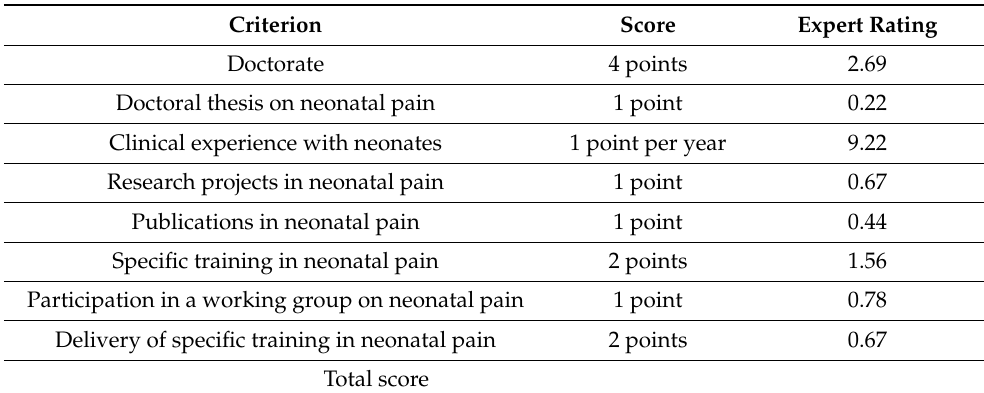
Table 2. Expert rating base on Quatrini’s criteria